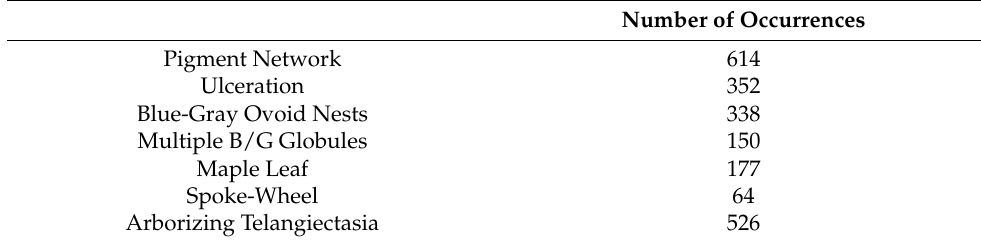
Figure 2. Top row, from left to right: telangiectasia, multiple B/G globules, ulceration and pigment network; bottom row: spoke-wheel, blue-gray ovoids and maple leaf. Table 1. Number of images for each pattern in the